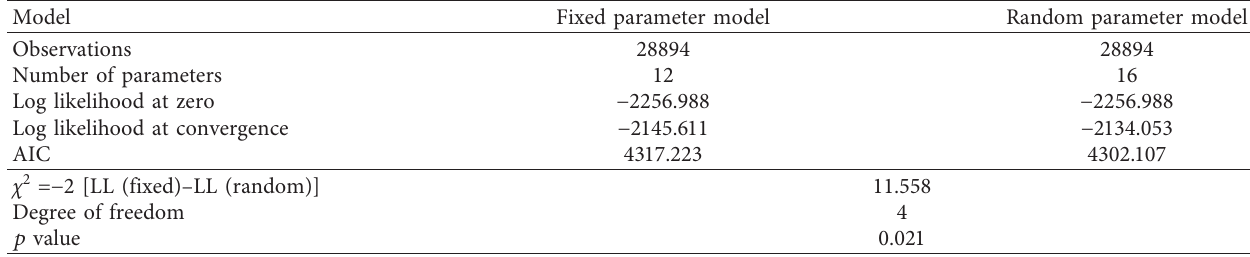
Table 2: Goodness-of-fit measures for fixed and random parameter models.